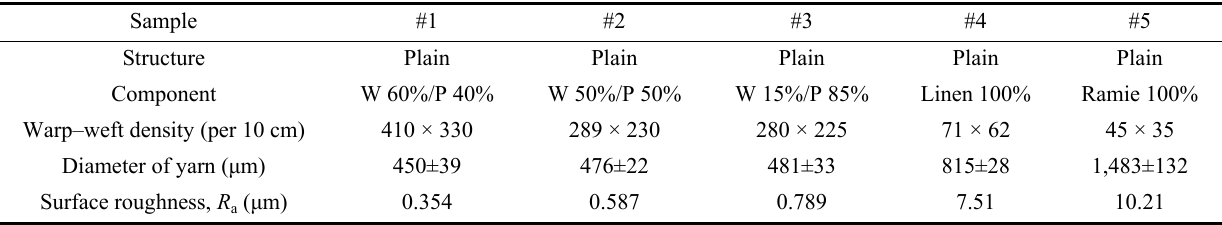
Fig. 1 Surface microscopy images of fabric samples: (a) #1, (b) #2, (c) #3, (d) #4, and (e) #5. Table 1 Structures, components, warp–weft densities, and surface roughnesses of fabric